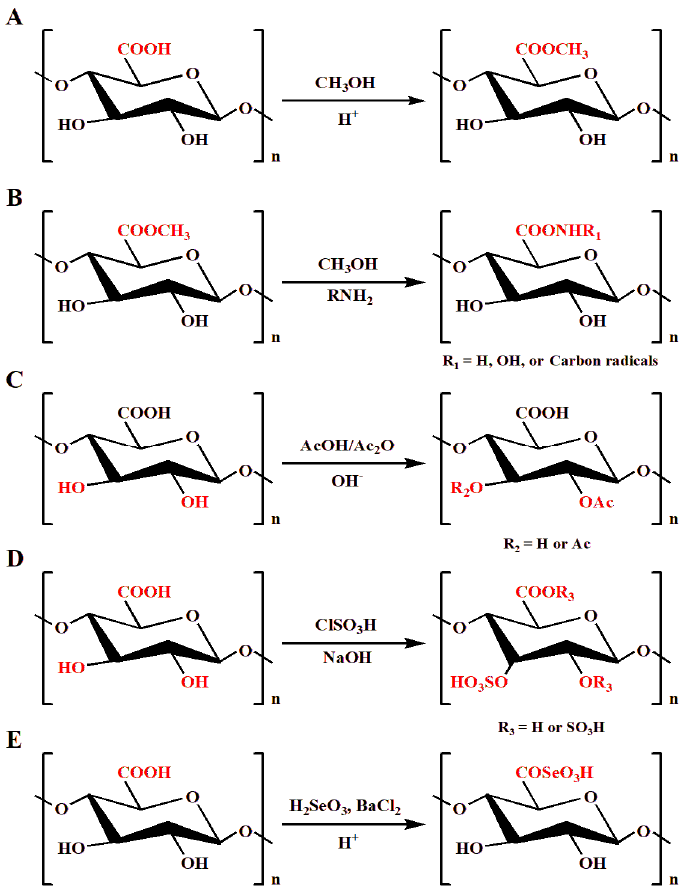
Figure 1. Methyl esterification ( A ), amidation ( B ), acetylation ( C ), sulfation ( D ), and selenylation ( E ) of pectin. Table 1. Summary of the methods for chemical and physical modifications of pectins.